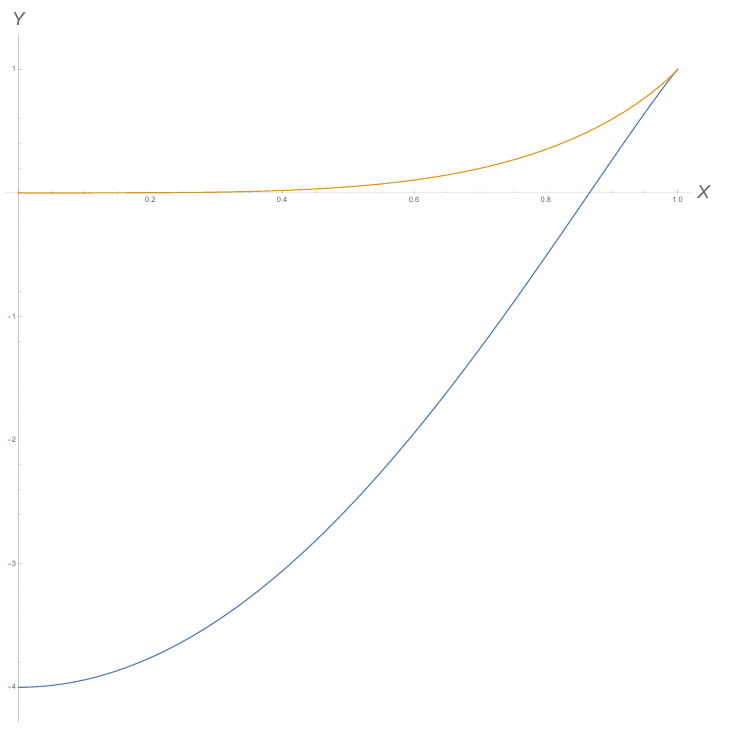
Figure 1 . The rescaled energy density, Y = 27∆ φ 3 Φ / Φ max , for the two branches of soliton solutions. The lower branch crosses the axis at X S = √ Φ S / Φ max = 3 / 2